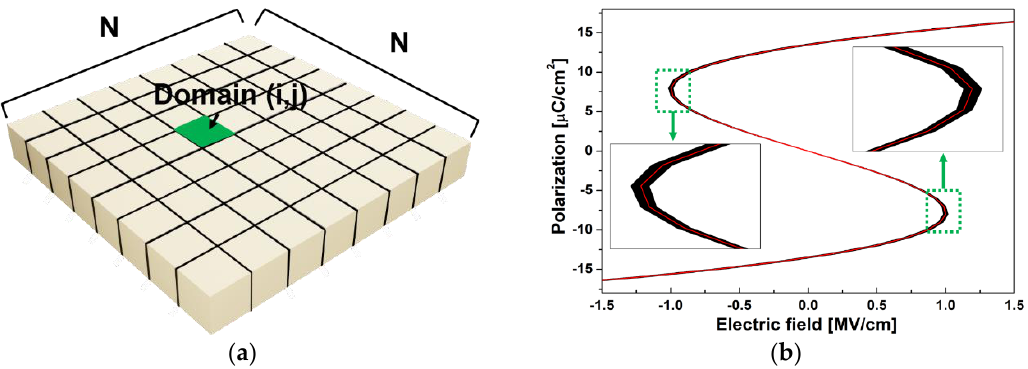
Figure 2. ( a ) Illustration of ferroelectric material containing N × N domains; ( b ) simulated polarization vs. electric field of multi-domain ferroelectric material. Black/red curve represents polarization vs. electric field of each domain/overall ferroelectric material, respectively.